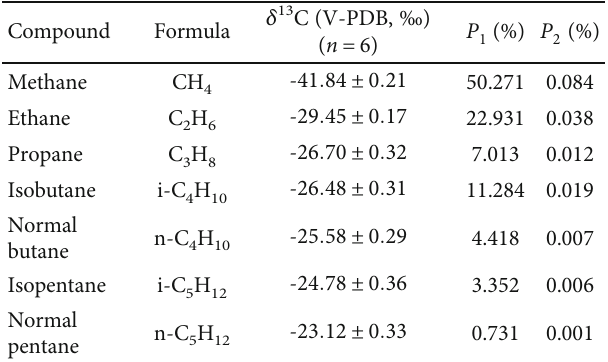
Table 1: Composition and carbon isotopic ratios of the standard sample.